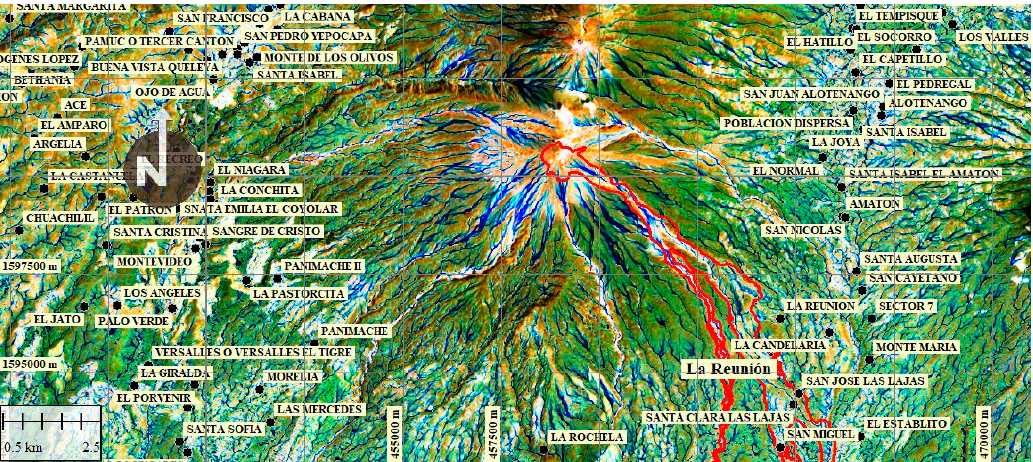
Figure 14. The flow paths, calculated by using the three morphometric indices TWI, LS, and FlowAcc 489 in SAGA, determined the areas that were flooded by primary and secondary lahars. 490 The field control was carried out by technicians of CONRED. 491